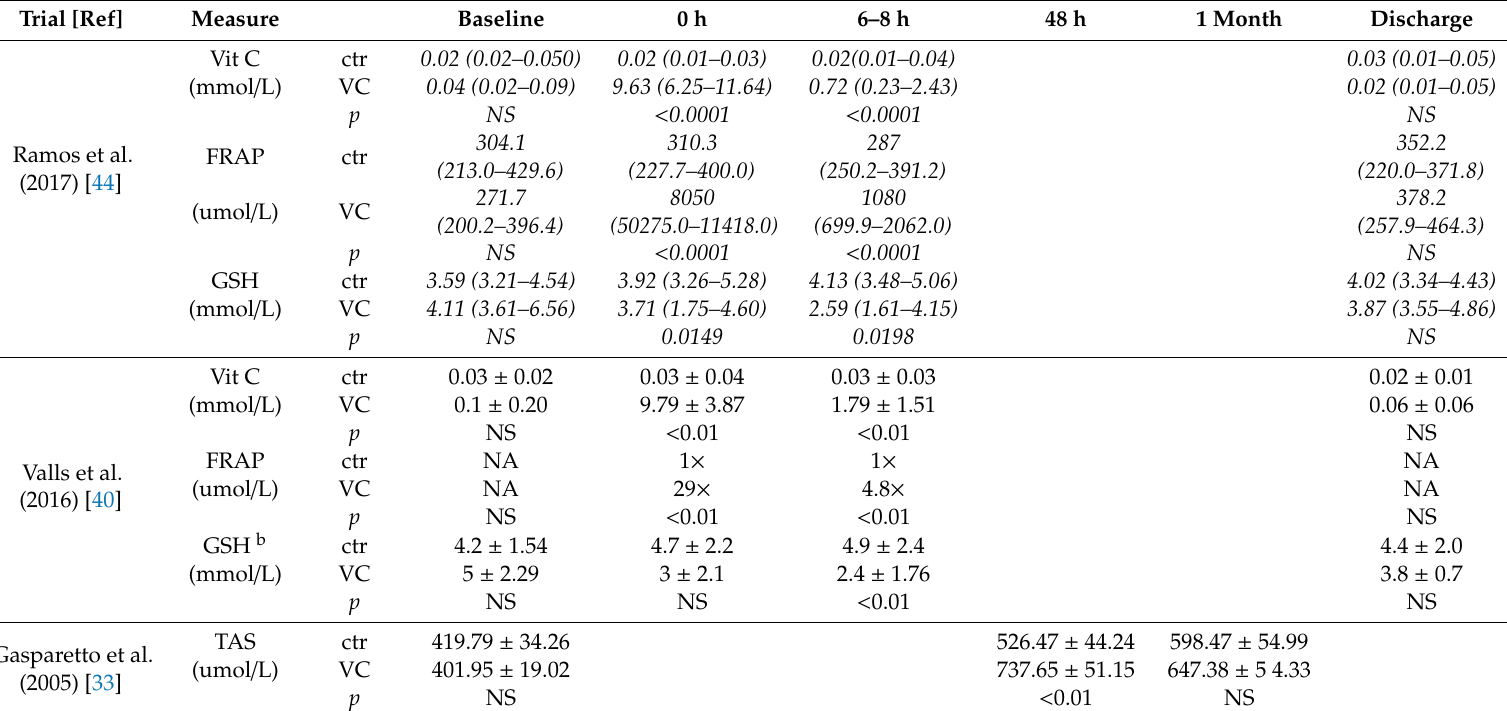
Table 3. E ff ect of Vitamin C on Antioxidant